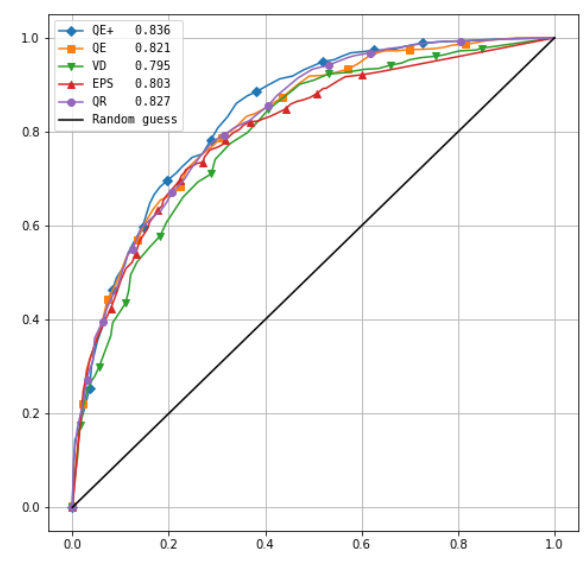
Figure 3. ROC curves for a threshold equal to half the clear sky power and for a forecast interval of 24–48 h. In the legend within the figure, the values of the area under the curve are also shown.